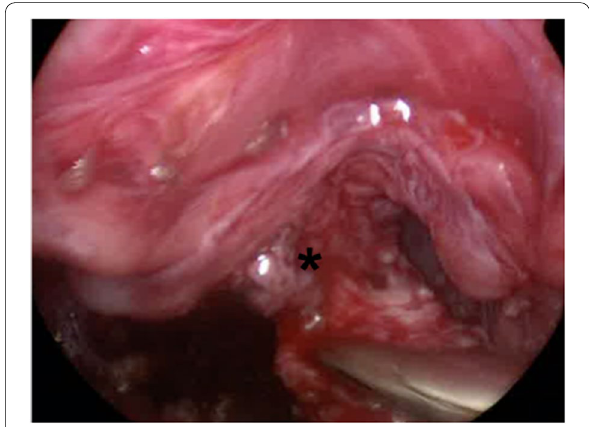
Fig. 1 Laparoscopic view showing the rectourethral fistula (*) during division